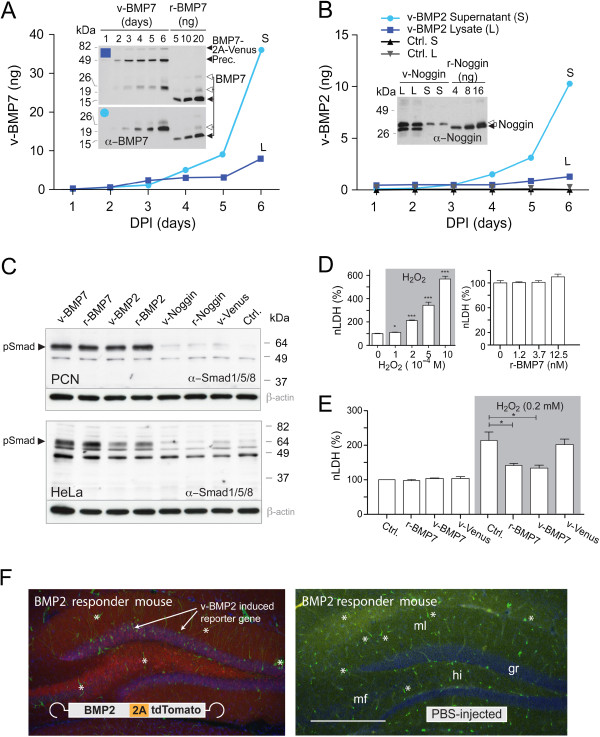
2A-released v-BMPs and v-Noggin are biologically active. A. BMP7 in lysates (L) and culture medium (S) of rAAV infected PCNs at different time points. Inset: Anti-BMP7 immunoblots of L (4 μl) and S (12 μl) used for quantification. B. Time course of v-BMP2 expression in PCN determined by ELISA of 4 μl L and 12 μl S. Inset: Noggin immunoblot of L and S of rAAV-Noggin-2A-Venus infected PCN at DPI 6. Precursor and released peptides are indicated by arrowheads; cystines containing forms by open arrows. C. Anti pSmad immunoblots of PCN (top) and HeLa cells (bottom) treated for 4 h with recombinant proteins or conditioned medium from rAAV infected PCNs as indicated. Ctrl.: non-infected PCN. Loading control: β-actin. D. left: H2O2 induced death of PCN as shown by lactate dehydrogenase (LDH) release 24 h after adding H2O2. Values are means ± SEM, One-way ANOVA, p < 0.0001. *p < 0.05, ***p < 0.0001 in comparison to untreated groups. D, E. Pretreatment with r-BMP7 (1.25 nM) and rAAV-mediated v-BMP7 expression reduced H2O2 induced LDH release in PCN. R-BMP7 was added 30 min before H2O2. One-way ANOVA, p < 0.0006. *p < 0.05 (Tukey’s posthoc test). LDH is given relative to controls (Ctrl.). F, V-BMP2 specific induction of the BMP responder GFP in BRE:GFP mice. RGB overlay fluorescent images of hippocampal DG region in coronal brain sections of (left) BRE:GFP mice injected with rAAV-BMP2-2A-tdTomato and (right) with PBS as control. GFP was visualized by anti-GFP (green), and cells nuclei with DAPI (blue). tdTomato auto-fluorescence is in red. Hilus region (hi); molecular layer (ml) of the dentate gyrus (DG); mossy fiber projections (mf). Arrows indicate GFP expressing cells in the granular cell layer (gr). Blood vessels show an unspecific fluorescence in both brain sections (stars). Scale bar; 0.5 mm.